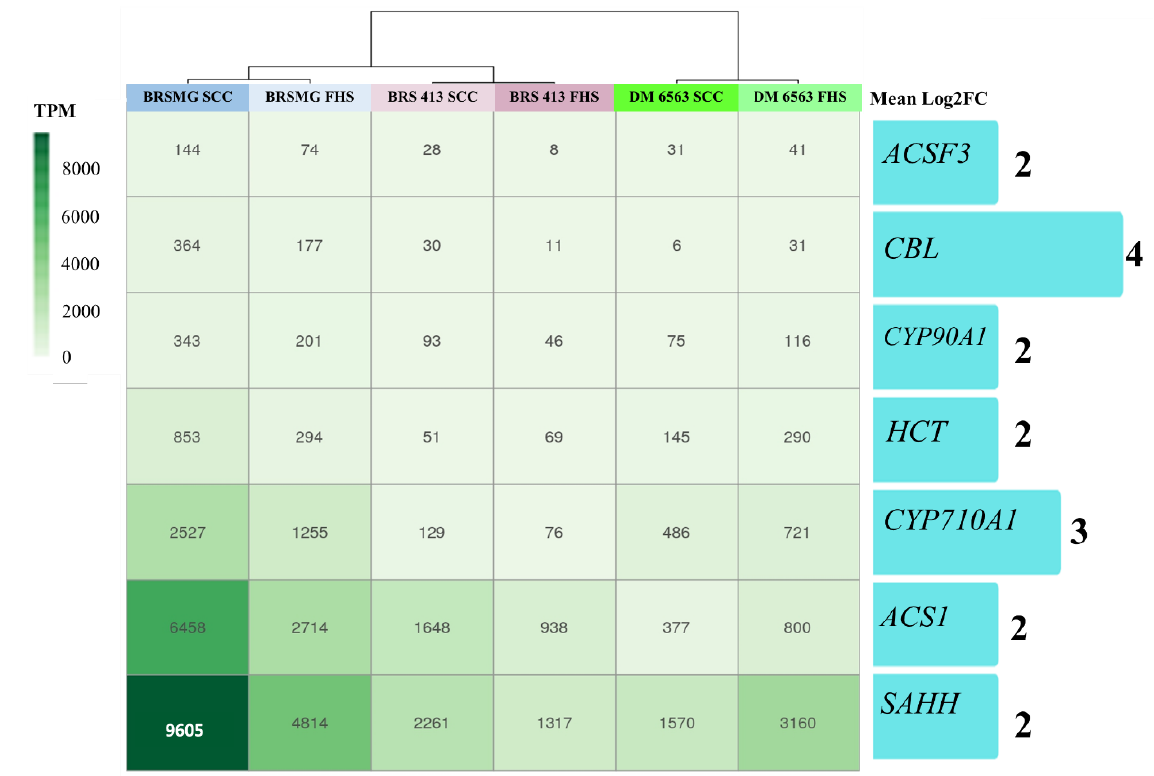
Figure 4. Heatmap containing absolute expression values in transcripts per million (TPM). Bars represent the relative expression in log2FC of the seven target genes. The selected genes were all up-regulated in the black seed coat cultivar BRSMG 715A of soybeans. The green boxes show the TPM values used to calculate the log2FC for each gene (blue bar).